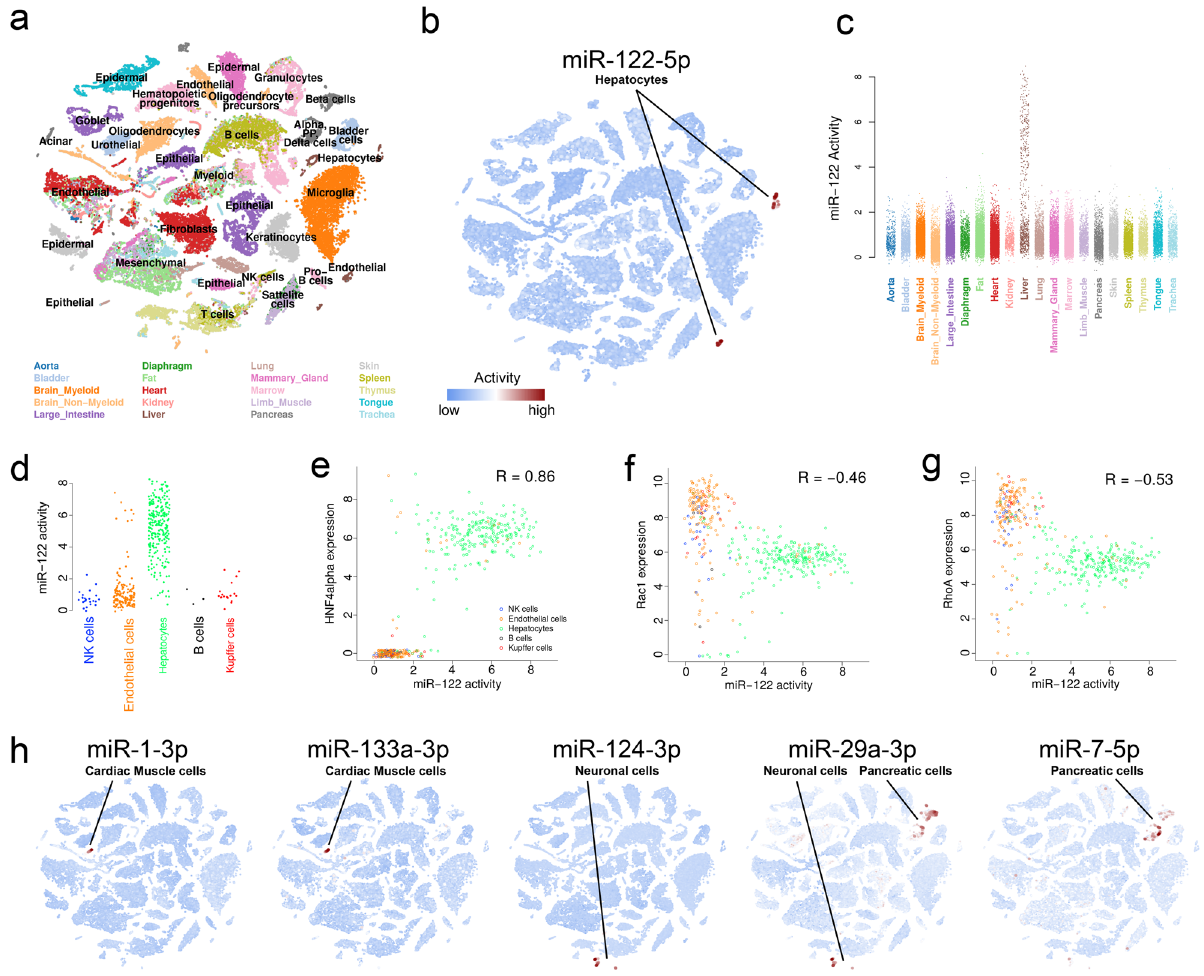
Figure 3. miRNA activity in single cells. a t-SNE plot showing clusters of cell types colored by tissue types for 42,192 cells of the Tabula Muris data set. Embeddings and cell annotations were obtained from the original work. b miR-122 activity overlaid the t-SNE embeddings as in ( a ) with indication of cell types for high activity cells. c miR-122 activity of individual cells separated into tissues. d miR-122 activity of individual liver cells separated into cell types. e,f,g Correlation between mir-122 activity and expression of the miR-122 transcription factor HNF4alpha ( e ), and miR-122 targets Rac1( f ), and RhoA ( g ). h miRNA activities overlaid t-SNE embeddings as in ( a ) with indication of cell types for high activity cells. Cells with less than 2000 expressed genes were removed in ( d-g